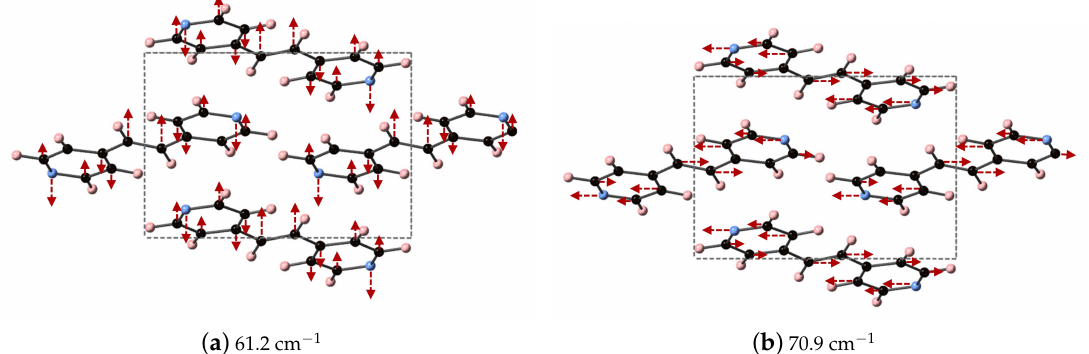
Figure 5. Depicted here are the DFT-D computed IR active vibrational modes of BPEth that occur at ( a ) 61.2 cm − 1 (along the y -direction) and ( b ) 70.9 cm − 1 (along the x -direction). The DFT and DFT-D computed isotropically averaged (cid:101) µ (ionic response) of BPEth are 0.32 and 0.27, while the directionally averaged (cid:101) α (electronic response) are 2.36 and 2.98. Inclusion of dispersion in DFT-D has decreased (cid:101) µ by 15.6% and increased (cid:101) α by 26.3%. Summed together, the averaged components of (cid:101) for BPEth using DFT and DFT-D are 2.68 and 3.25, respectively, comparable to the values of 2.68 and 3.92 for